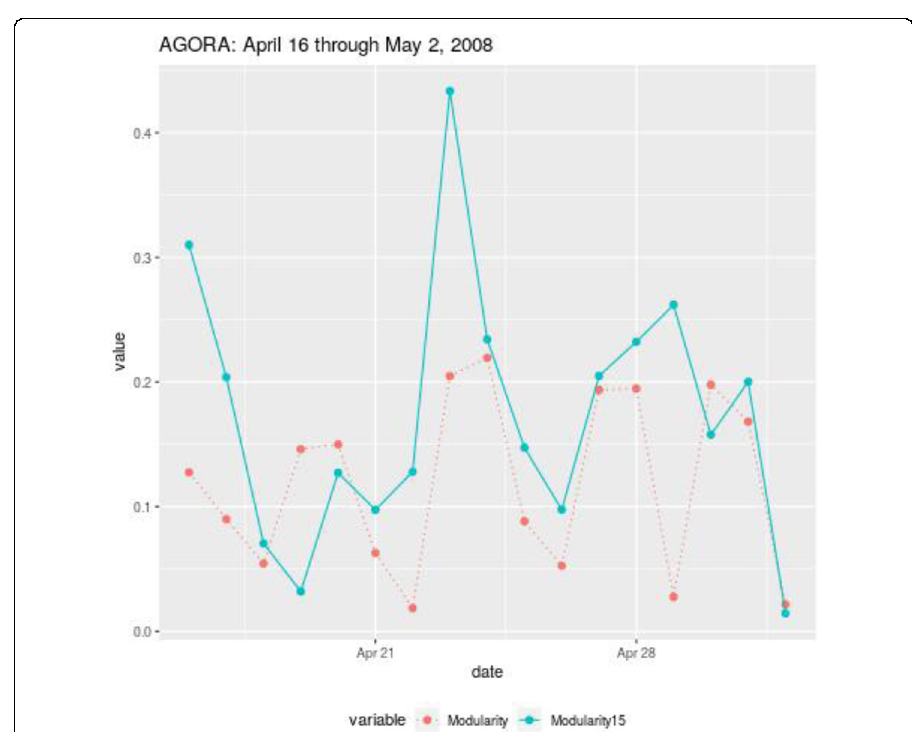
Fig. 2 Note: Modularity scores of topic networks. Note : Modularity is a network value showing the strength of cohesive subgroups by comparing their intra-community ties to inter-community ties. High modularity may signify that a network has cohesive communities whose inter-community relations are relatively weaker, whereas low modularity indicates a network has stronger inter-community relations. The blue solid line represents modularity scores from topic networks that have 15 terms, whereas the red dotted line shows those from topic networks with 30